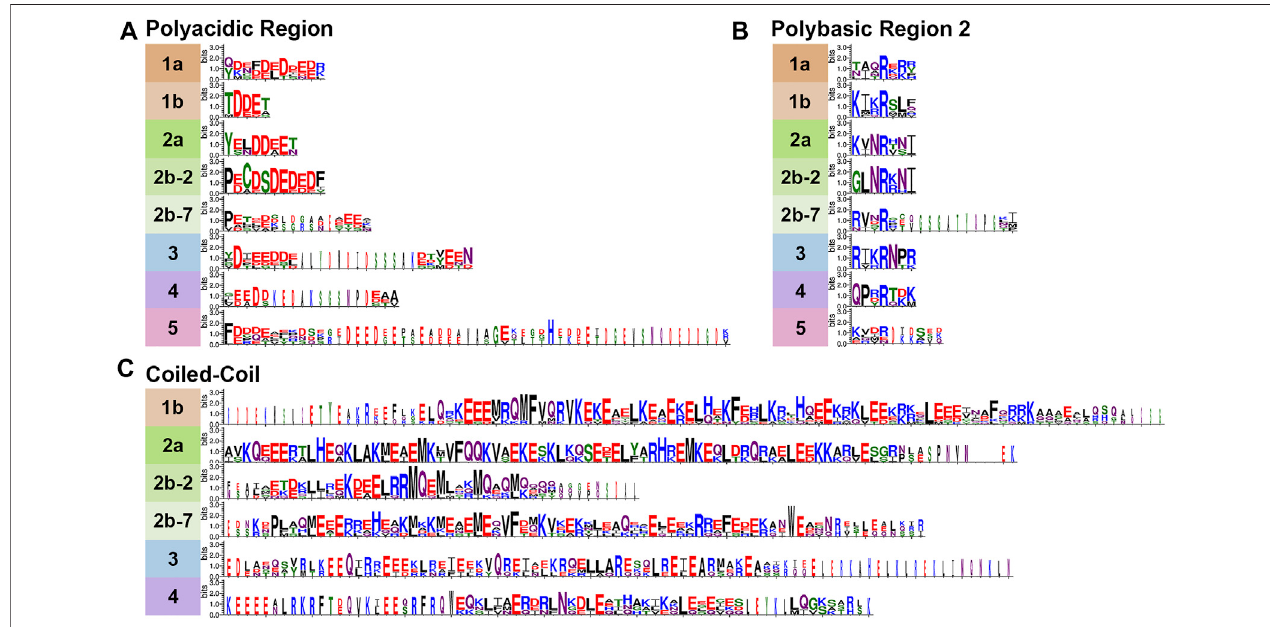
FIGURE 3 | Variable Septin domains. Septins were aligned using Clustal Omega (Madeira et al., 2019) and WebLogo 3 (Crooks et al., 2004) was used to view variable septin domains. (A) The polyacidic, (B) polybasic 2, and (C) coiled-coil regions vary between groups in size and residues.